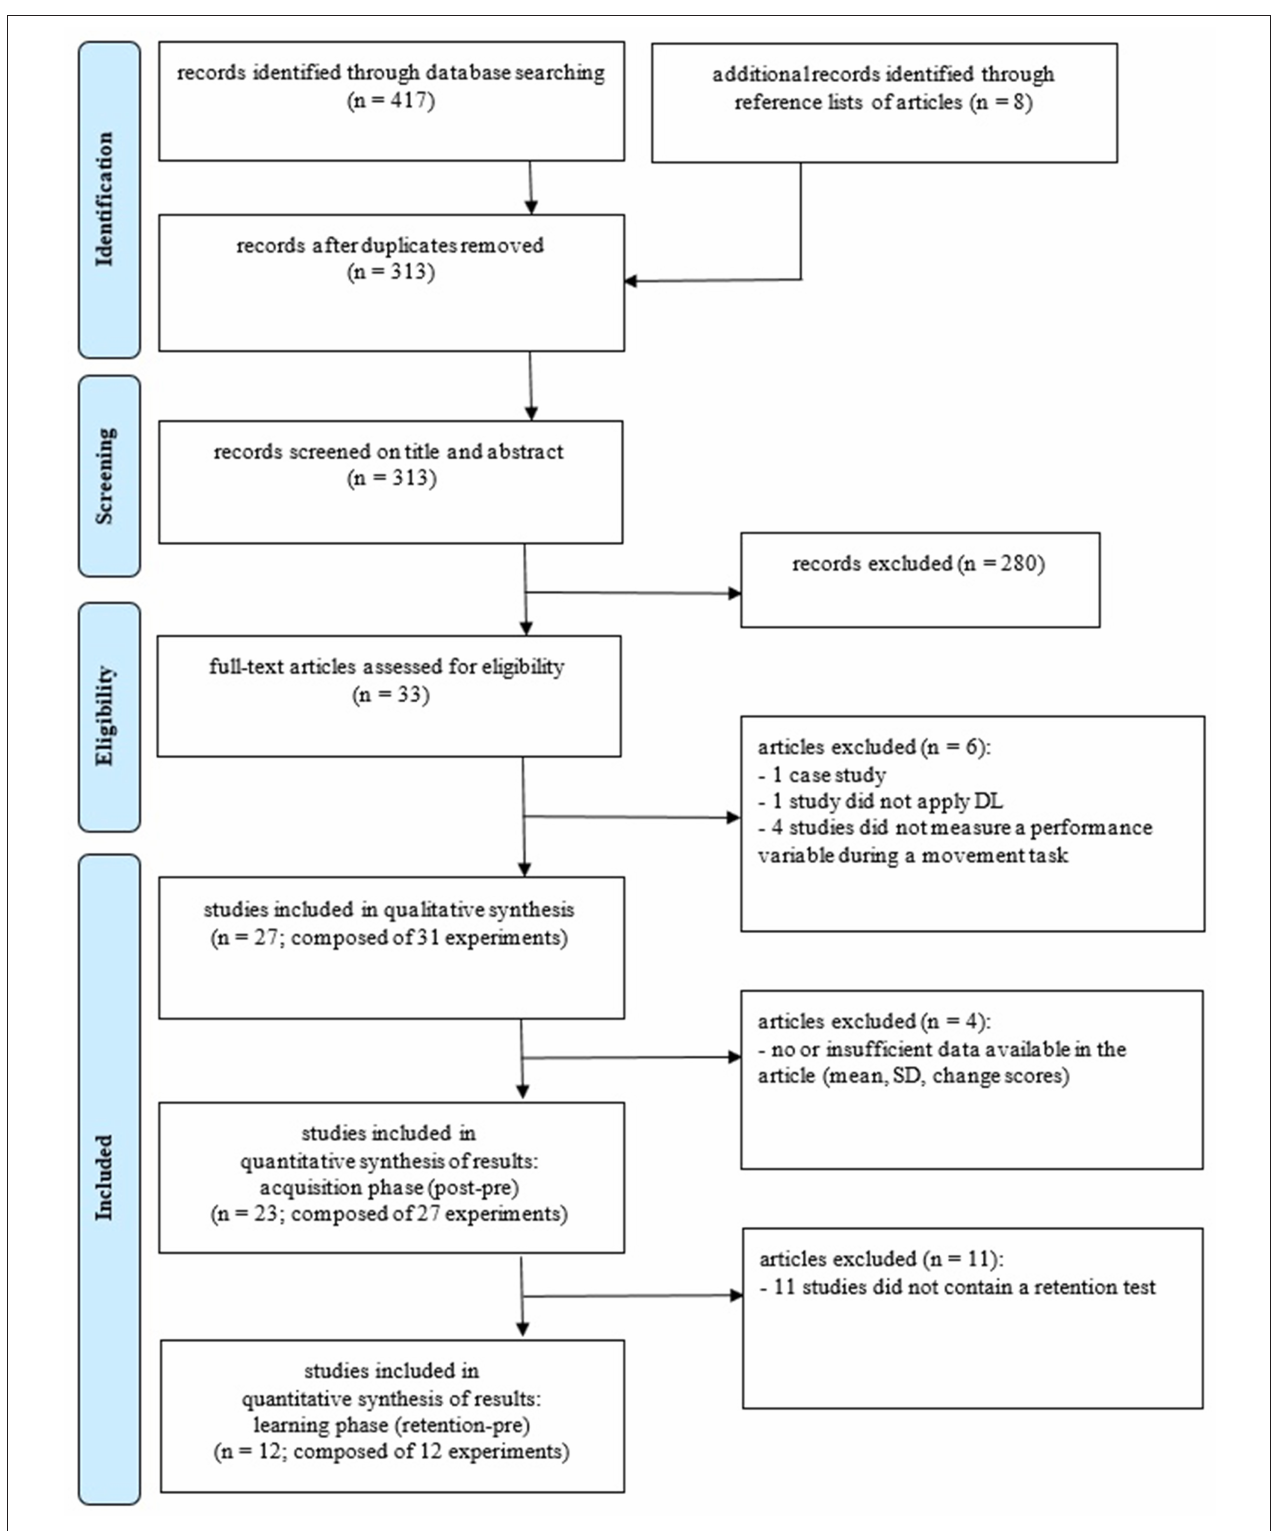
FIGURE 1 | Flowchart of the search and screening process (based on the PRISMA statement template). DL, differential learning; TL, traditional learning; CtIt, contextual interference; SL, structural learning (Moher et al., 2015).